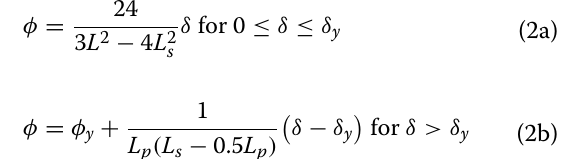
Fig. 6 Reduced confinement of cover concrete under impact